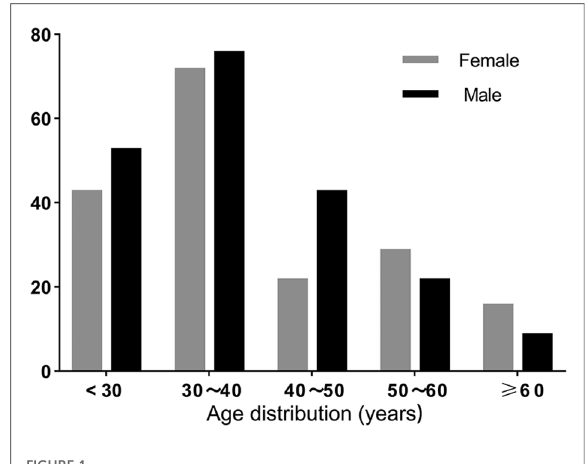
FIGURE 1 The composition of participants in each age strati fi